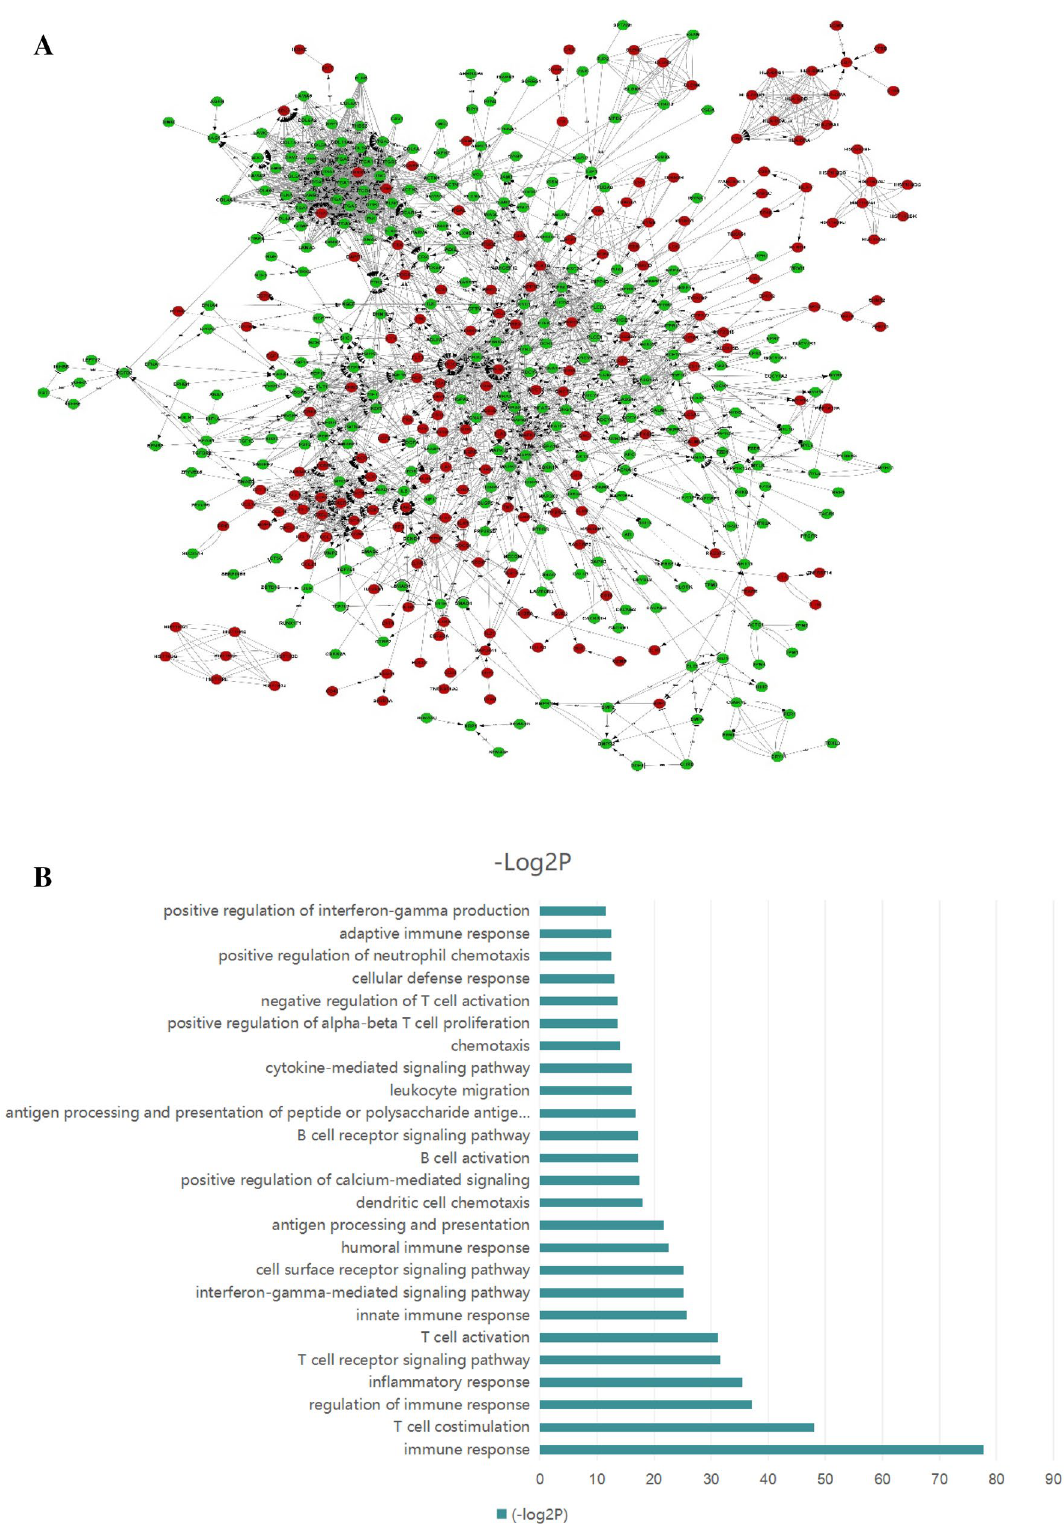
Figure 2. The results of transcriptome analysis. ( A ) Interaction network of DEGs (red: upregulated genes, green: downregulated genes). ( B ) Top 25 enriched biological processes for upregulated DEGs. ( C ) Top 25 enriched biological processes for downregulated DEGs. ( D ) Top 25 pathway enrichment analyses for upregulated DEGs. ( E ) Top 25 pathway enrichment analyses for downregulated DEGs. ( F ) DEGs mapped with KEGG FcεRI signaling pathway (green: upregulated, purple: